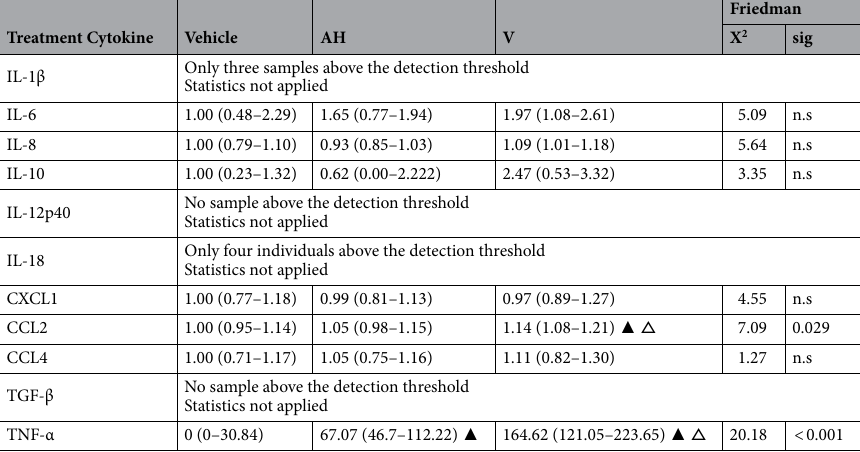
Table 2. Cytokine quantification into differentiated PBMCs exposed 4 h with Al-based treatments. Results are expressed as median and quartiles (in brackets) of cytokine pixel signal/internal positive control. When possible, results were normalized by vehicle median. AH, Aluminum oxyhydroxide. V, Whole vaccine (Engerix ® ). n.s ., not significant. ▲ p < 0.05 to Durbin-Conover post-hoc test compared to vehicle treatment. △ p < 0.05 to Durbin-Conover post-hoc test compared to AH treatment.